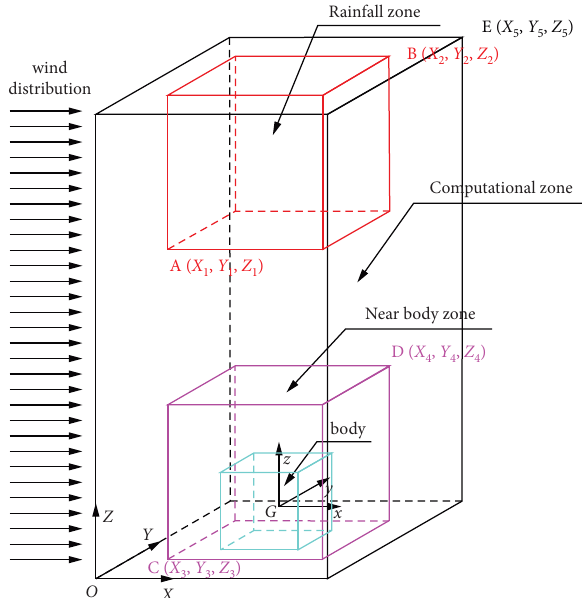
Figure 2: Spatial division of computational domain.